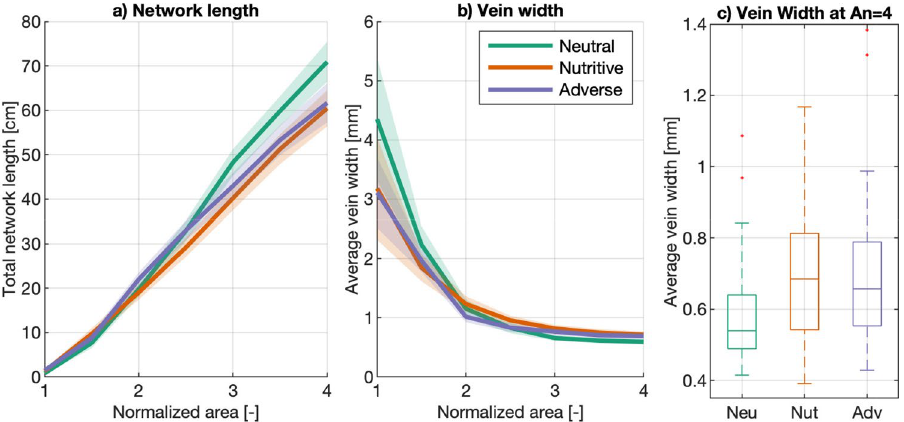
Figure 7. Total Network Length and average vein width. ( a ) total network length as a function of normalized slime mold cell area (An). ( b ) Average vein width of the network as a function of normalized slime mold cell area (An), computed as the ratio between the slime mold area and the total network length. ( c ) Boxplot graph of the average vein width at An = 4. The solid lines and shaded areas correspond to the means and confidence intervals among replicates, respectively. Box plots show median (horizontal line), interquartile range (box), distance from upper and lower quartiles times 1.5 interquartile range (whiskers), and outliers ( > 1.5 x upper or lower